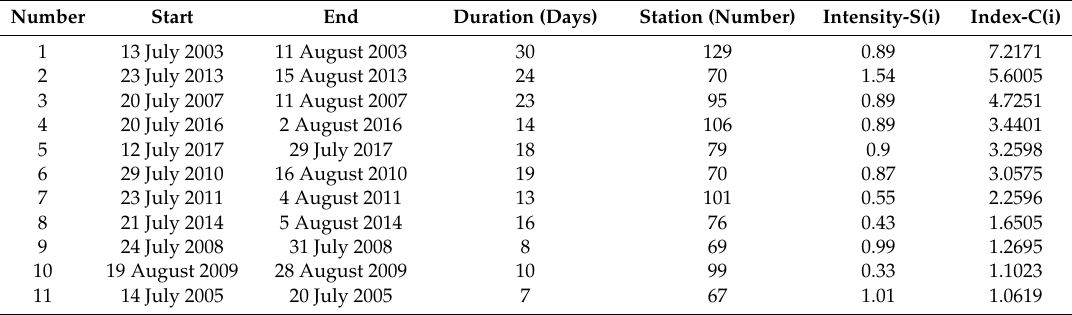
Table 1. The top 11 extreme heat-wave (EHW) events in southern China from 2000 to